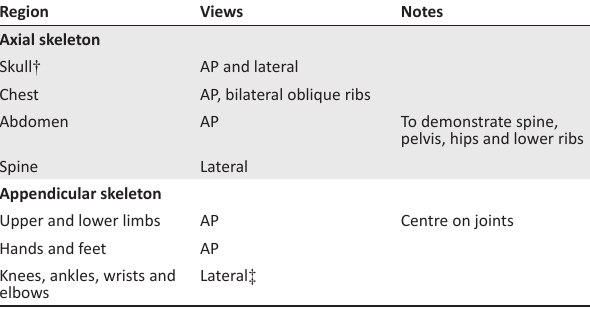
TABLE 1: Skeletal survey views for non-accidental injury.